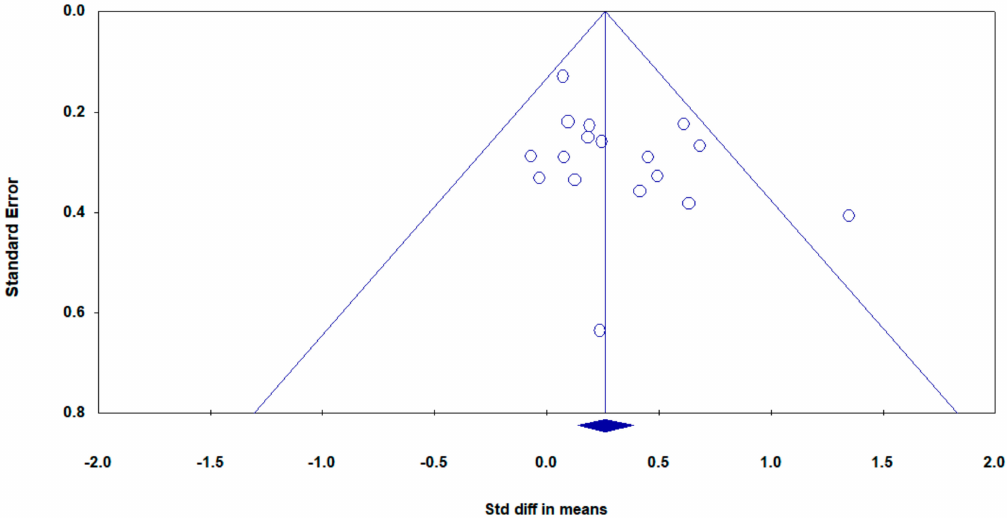
Figure 5. Funnel plot of the combined intervention group vs. the control